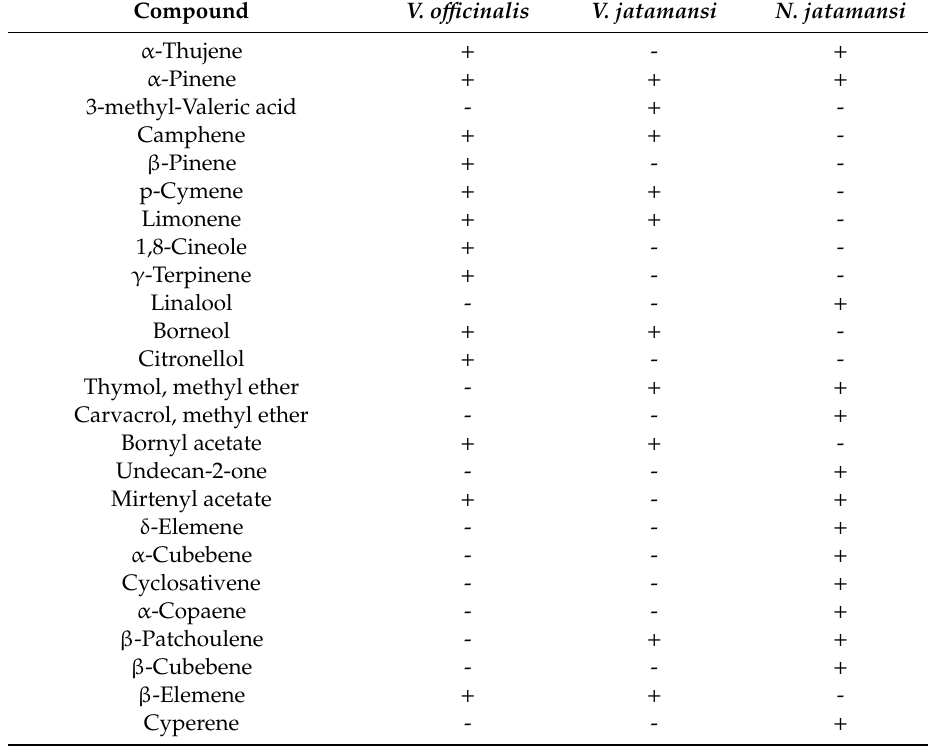
Table3. Phytochemicalsidentifiedinthepresentstudyandalreadyelucidatedinpreviousinvestigations on essential oils of Vo, Vj and Nj. + found; - not